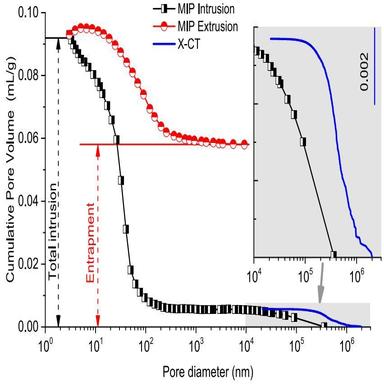
Representative APSDs from the intrusion and extrusion branches obtained by MIP and X-CT (sample P-04-600).